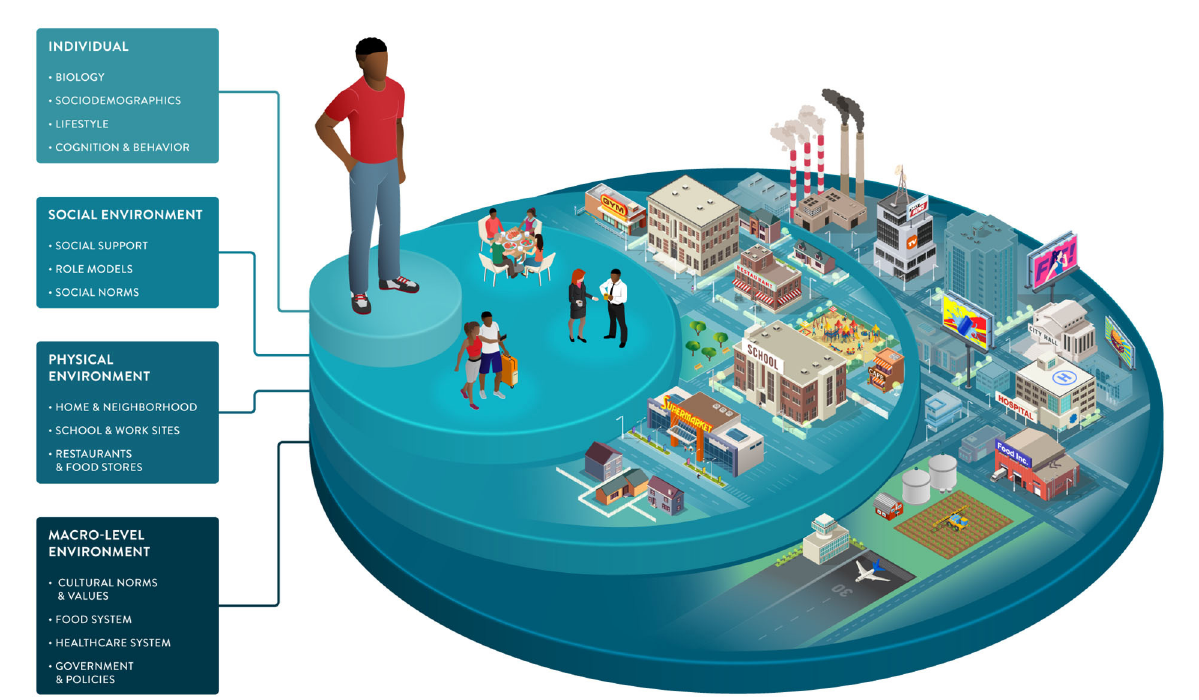
FIGURE3 Socio-ecological framework highlighting individual, social, and environmental dimensions that can drive dietary behaviors and responses. Sociodemographic characteristics and the environments in which we live influence our food choices and interact with many of the individual factors impacting our health and wellbeing. The framework illustrates the multiple dimensions that can be considered to understand dietary choices better and enable healthy behavior change tailored to individuals and their